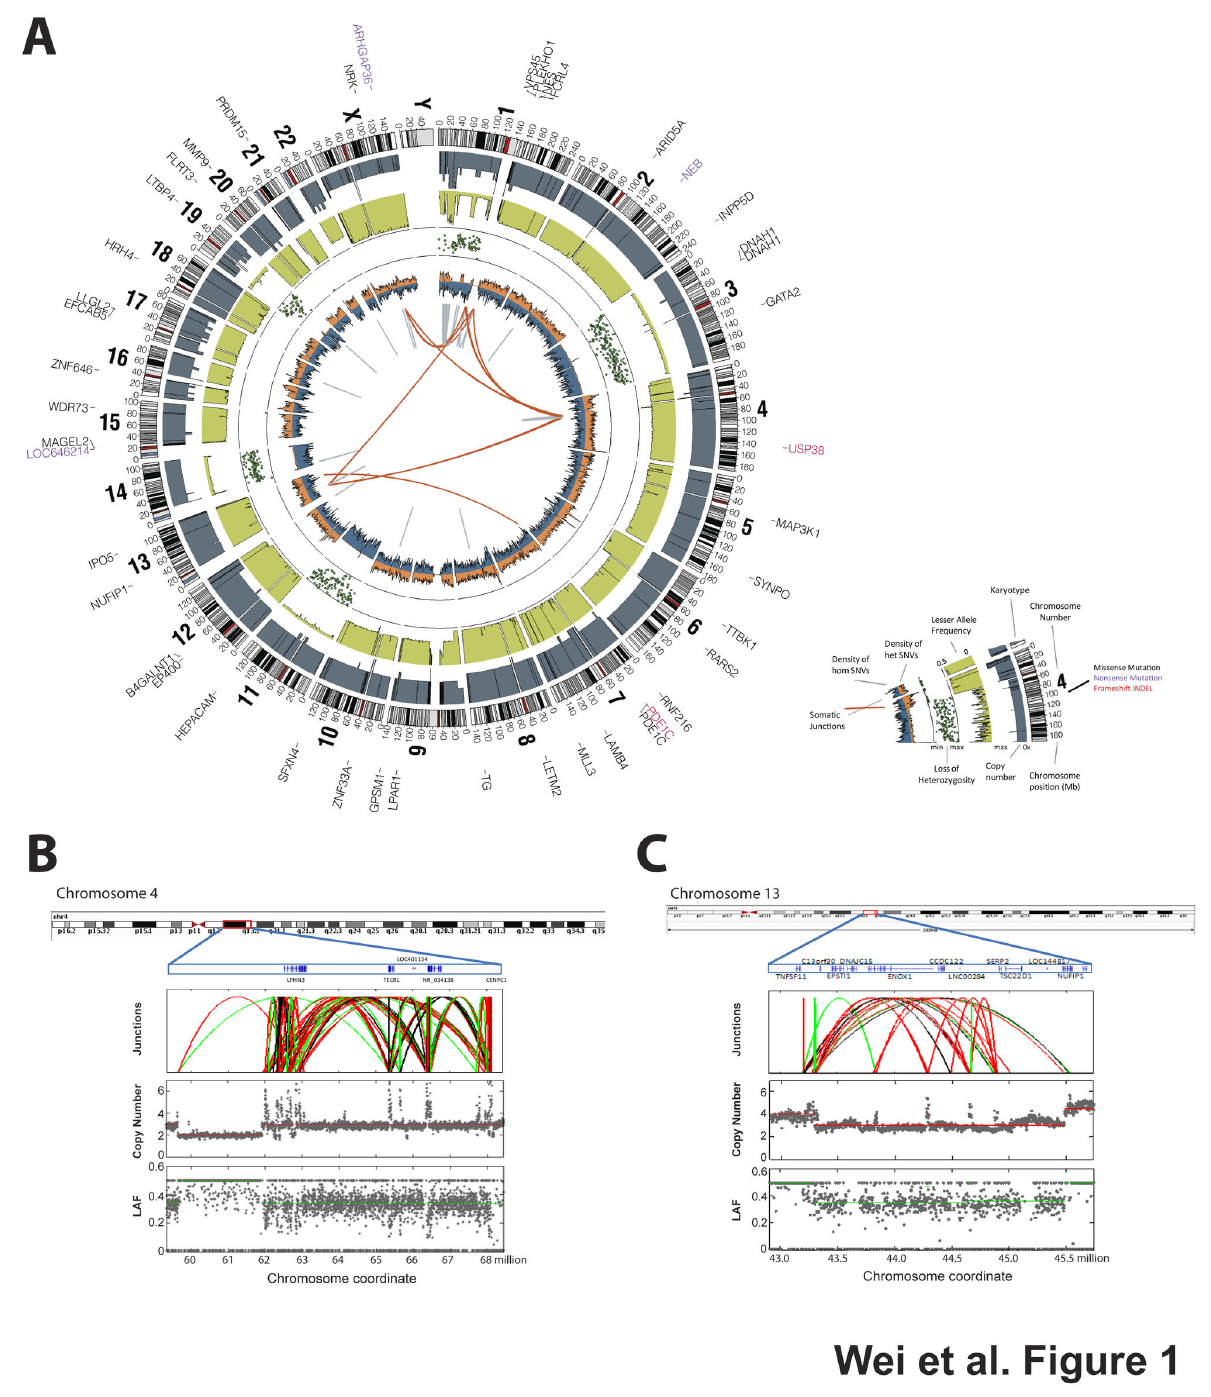
Figure 1. Whole genome sequencing of tumor Met2 and paired germline DNA revealed extensive somatic alterations in tumor DNA. ( A ) A CIRCOS plot shows non-synonymous somatic mutations, copy number changes, lesser allele fraction, loss of heterozygosity (LOH), and abnormal junctions in the Met2 tumor genome. ( B , C ) Chromothripsis was evident by massive complex rearrangements detected at chromosomes 4q and 13p by whole genome sequencing. In the junction plots, black, green, and red lines represent deletions, tandem duplication, and inversion respectively. Each dot in the copy number and LAF plots represents a 2 kilobases DNA fragment, and red and green lines mark the average segmental copy number and LAF respectively. LAF, lesser allele fraction. doi: 10.1371/journal.pone.0077731.g001 PLOS ONE |